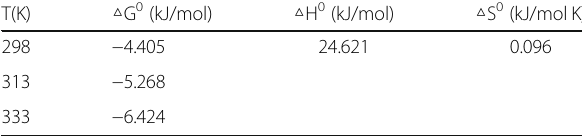
Table 2 The thermodynamic parameters of △ H 0 , △ S 0 and △ G 0